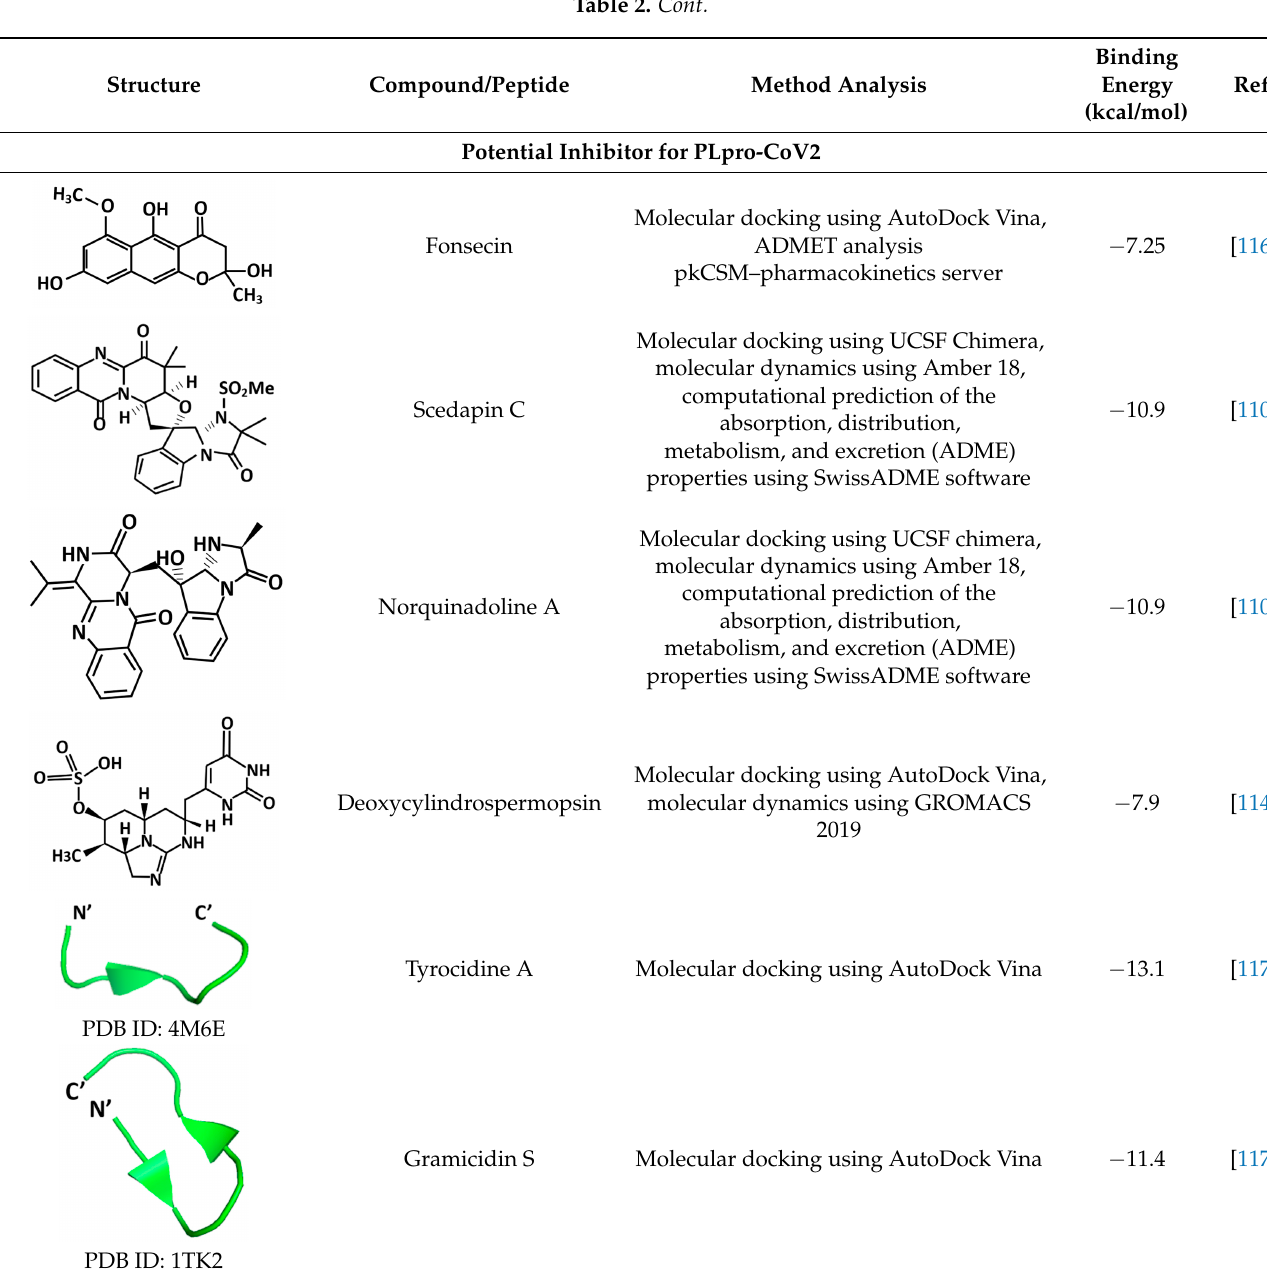
Note: The structure of peptide-based compounds are displayed in their three-dimensional structure. Table 3. Plant compounds thar are screened against SARS-CoV-2 proteases. Compound